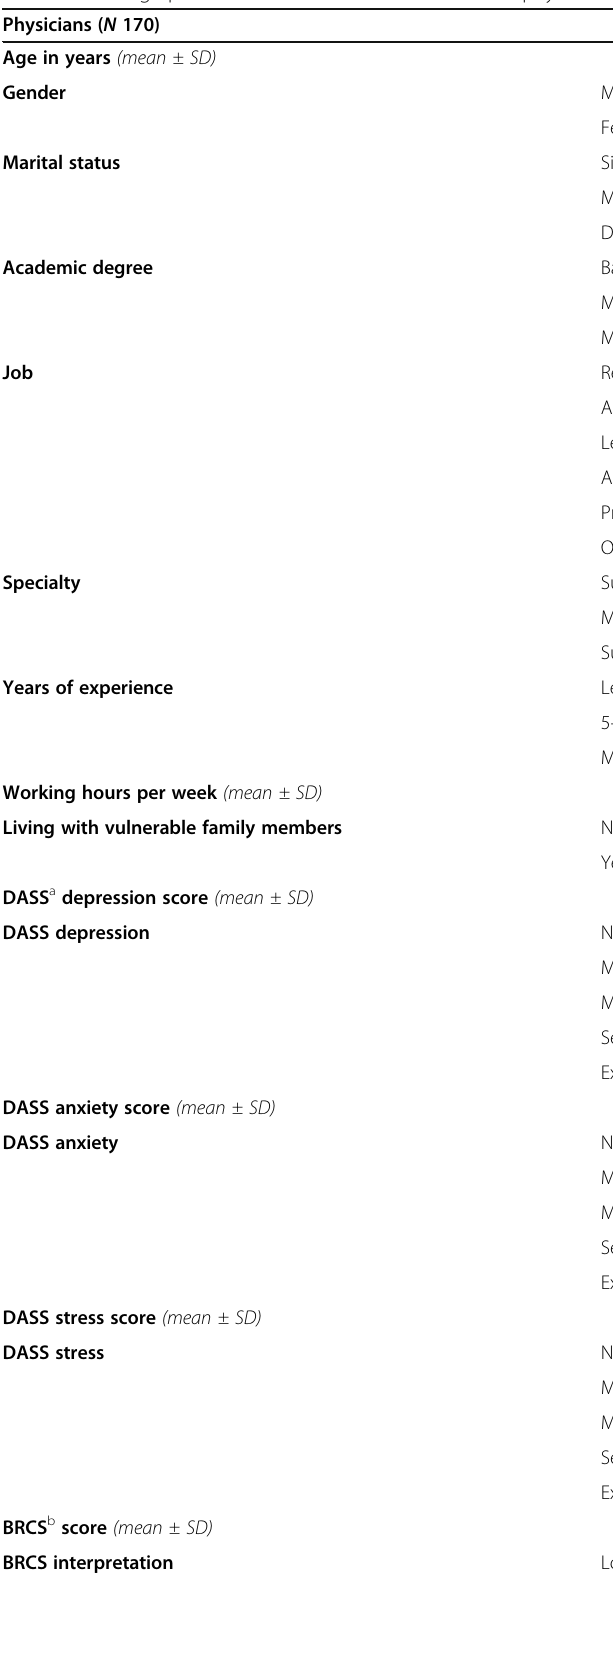
Table 3 Demographics and clinical characteristics of the